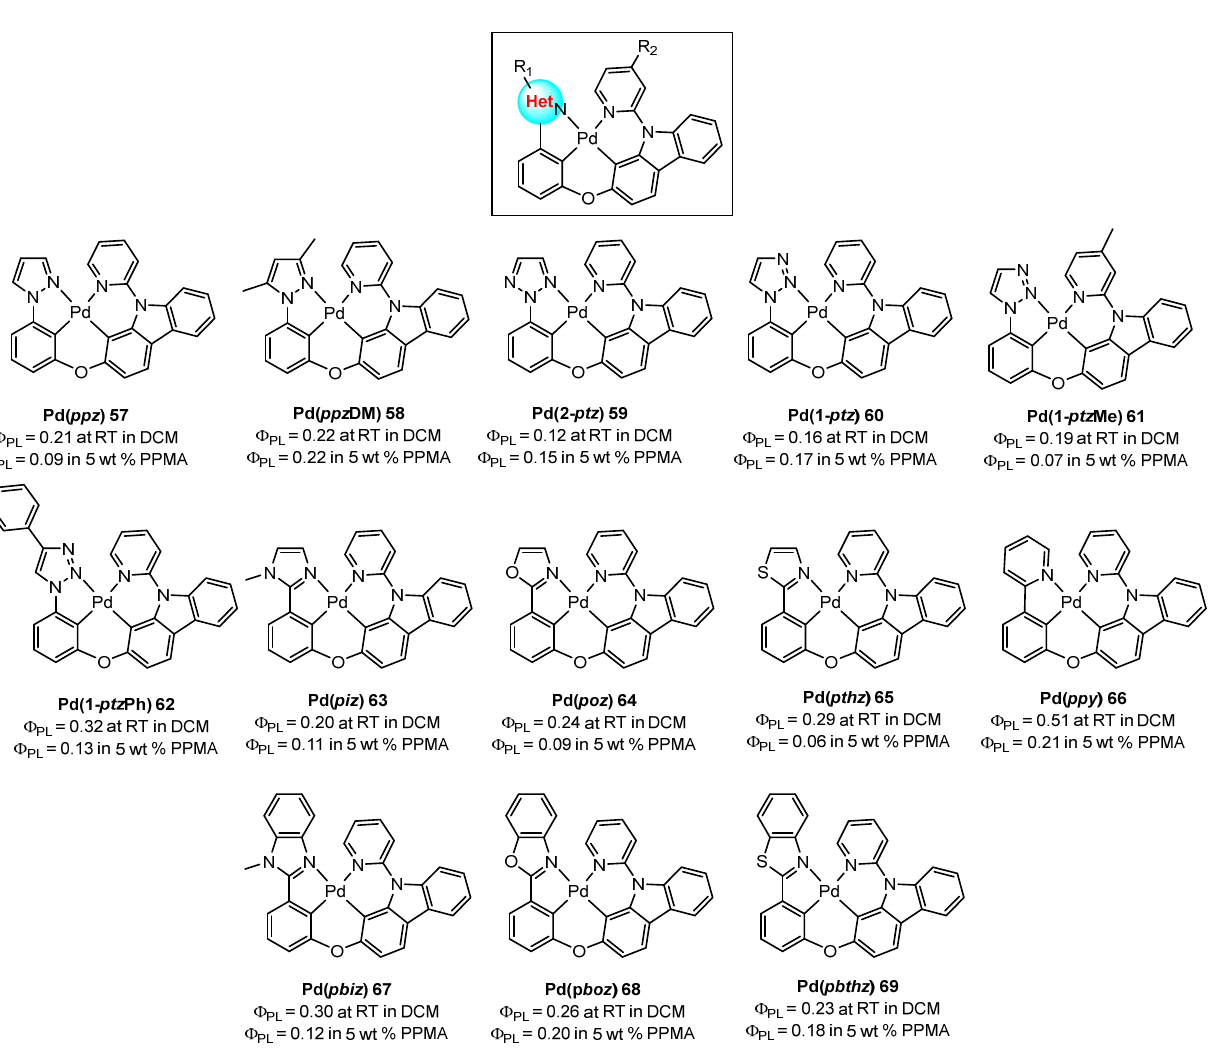
Figure 20. Synthesis and chemical structures of the 5/6/6 Pd(II) complexes 57 – 69 with tetradentate ligands. Adapted from [84,85].